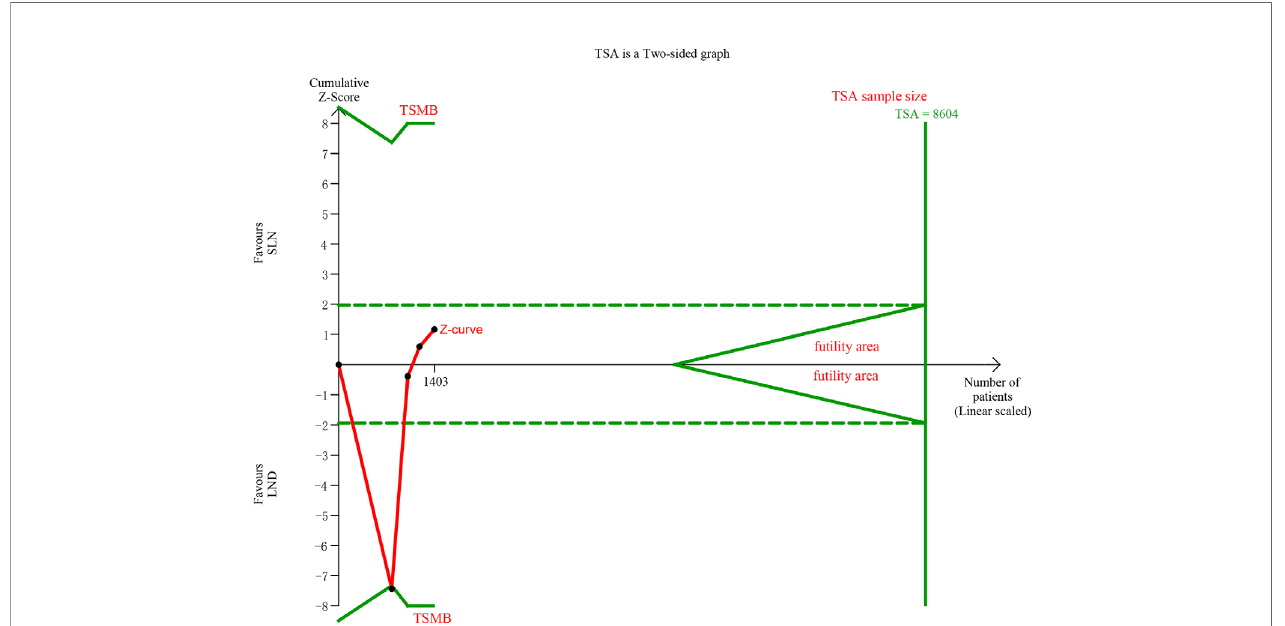
FIGURE 12 | TSA of para-aortic lymph nodes removed, a = 0.05, b = 0.8, two-sided